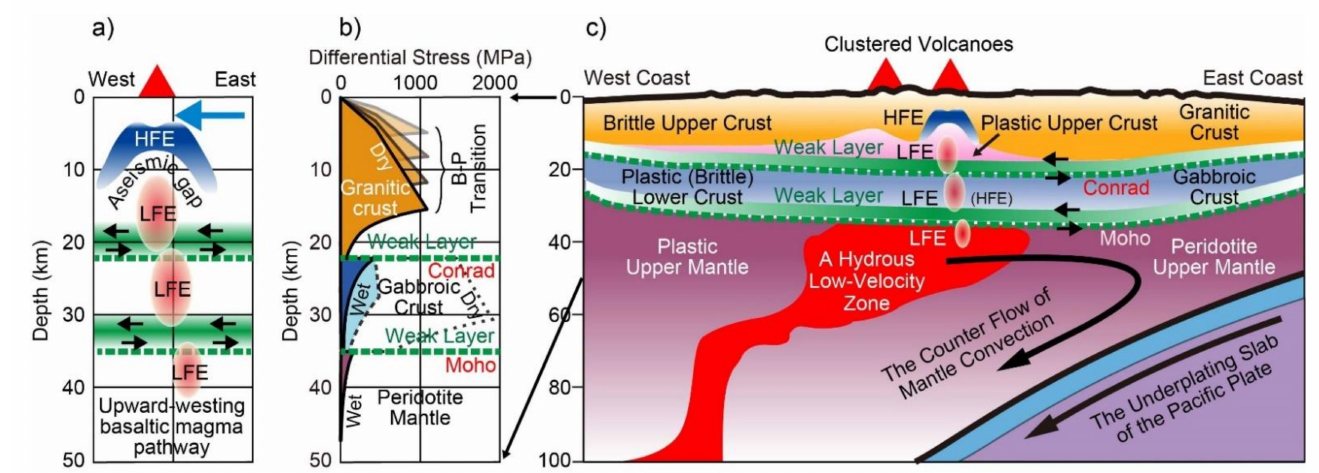
Figure 4. A model of the distribution of the LFEs and HFEs in volcanic fields, northeastern Japan. ( a ) Simplified spatial distributions of the LFEs and HFEs in volcanic fields in northeastern Japan. ( b ) Vertical three LFE clustering are explained by the strength envelope models in the three lithological layers. ( c ) A model of the basaltic magma replenishment systems to the subvolcanic magma chambers beneath the volcanic fields where the counter flow of the mantle convection to the underplating Pacific Plate results in the small lateral deviation of the basaltic magma conduits from the ENE to WSW directions as the LFEs move to shallower